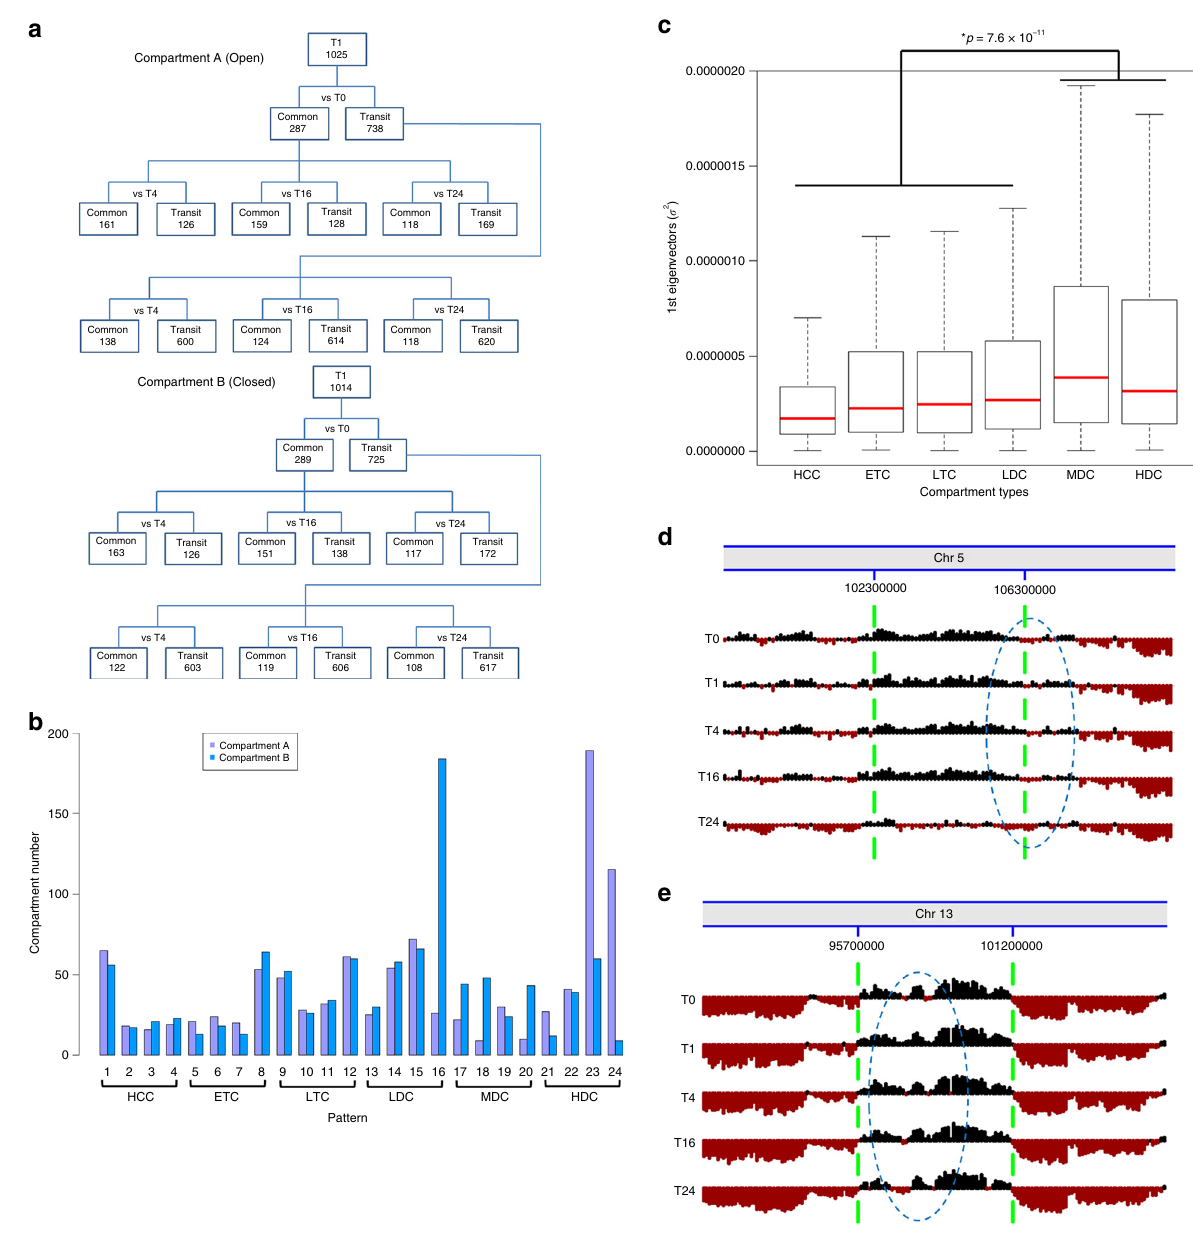
Fig. 2 Determination of E2-induced TDRCs in MCF7 cells. a An instructive tree of comparing compartments A (Top) and B (Bottom) at E2-induced fi ve time points. T0: control, T1: 1 h; T4: 4 h; T16: 16 h; and T24: 24 h. b A number of compartments at each of 24 individual patterns categorized into six types, including HCC with patterns 1~4; ETC with patterns 5~8; LTC with patterns 9~12; LDC with patterns 13~16; MDC with patterns 17~20; HDC with patterns 21~24. c The variance ( σ 2 ) of fi rst eigenvector values of compartment types in T0, T1, T4, T16, T24. The p value was determined by Wilcoxon rank-sum test. d , e Examples of compartment changes, MDC ( d ) and HDC ( e ) along E2-induced fi ve time points. Dark: Compartment A; Dark red: Compartment B. Compartments are indicated between green dash lines. Blue dash ovals highlight the dynamic region. TDRC temporally dynamic re- compartmentalization, MDC moderately dynamic compartments, HDC highly dynamic compartments